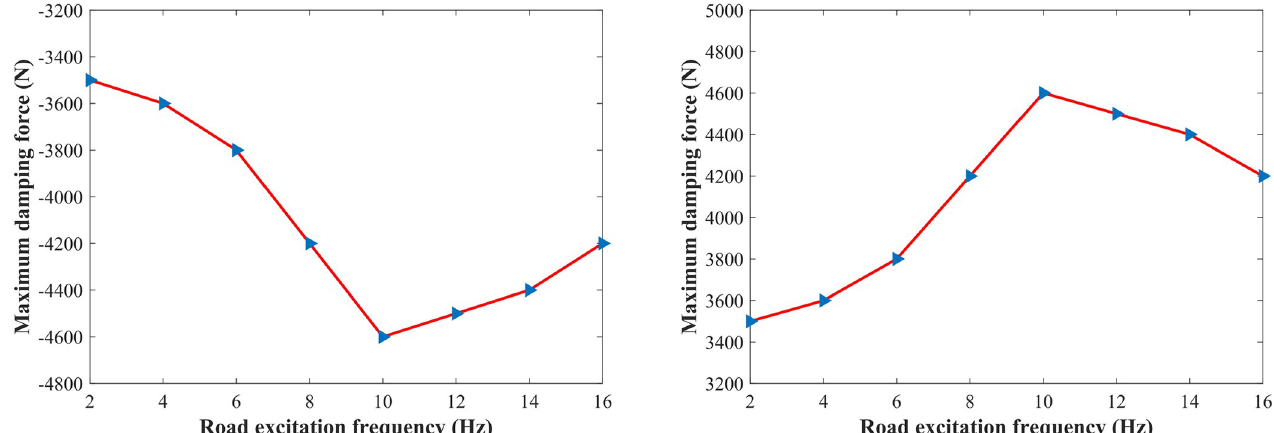
Fig 17. Maximum damping force required for shifting the vehicle body at different road excitation frequencies. (A) Vehicle body raises; (B) Vehicle body drops.